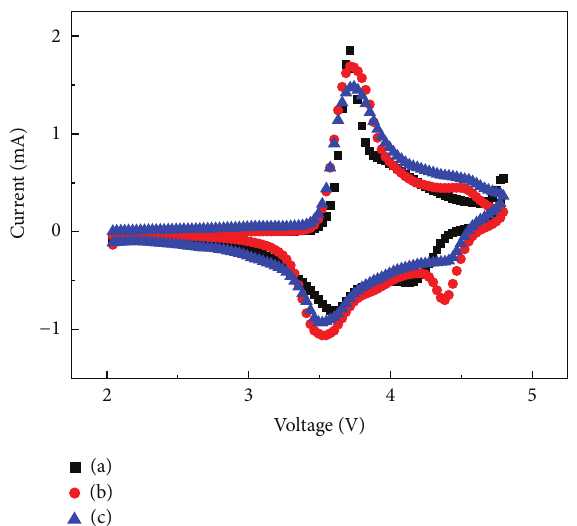
Figure 9: Cyclic voltammograms for LiNi 0.7 0.1 ) powders for 𝑥 = 0.00 (a), 0.05 (b), and 0.10